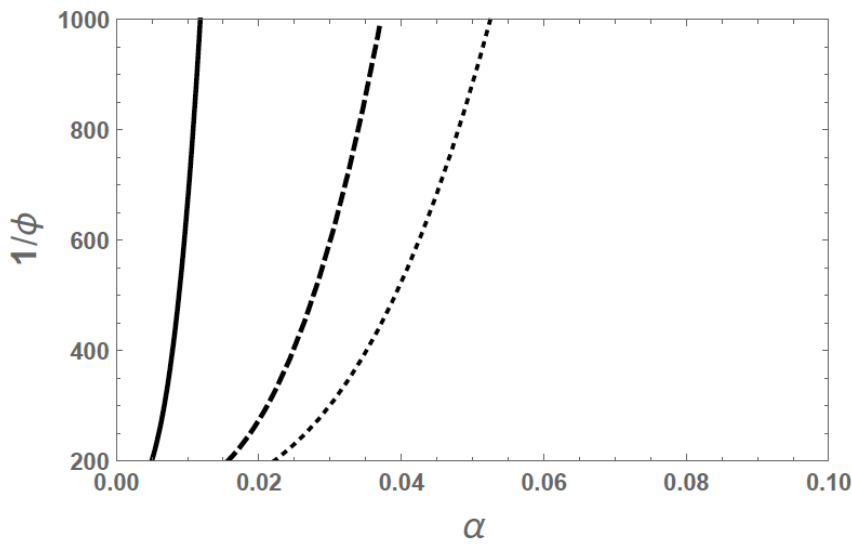
Figure 6. Dependence of the swelling ratio on degree of ionization and intermediate salt concentra- tions for χ = 0, φ 0 = 0.008, and N = 100. c s v 1 = 0.001 (solid), 0.01 (dashed), and 0.02